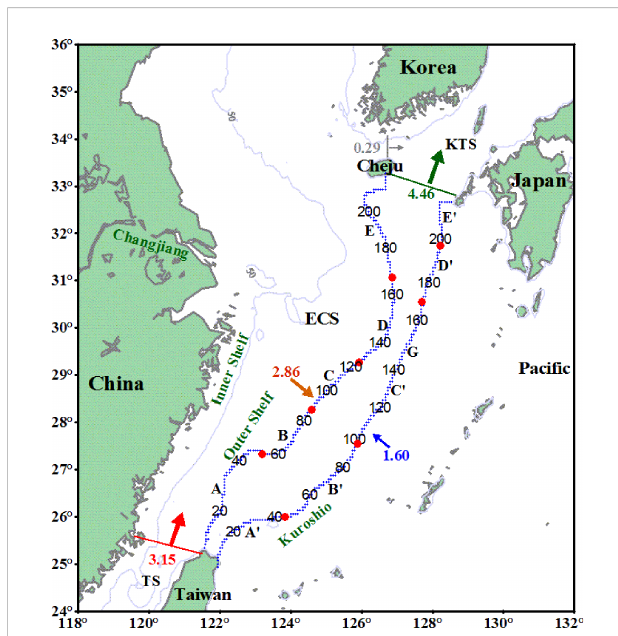
FIGURE 2 Water budgets through the Taiwan Strait (TS), the 100 – and 200 – m isobaths, East of Cheju (EC), and the Cheju Strait (CS) in the ECS. The blue dots along the 100 – and 200 – m isobaths indicate the grid number used for the water budget calculation. The number by each arrow indicates volume transport (Sv) through that section and the arrow indicates the direction of transport. The 100 – and 200 – m isobaths are separated into different sections (A to E along the 100 – m isobaths and A ’ to E ’ along the 200 – m isobath) according to the reversal of